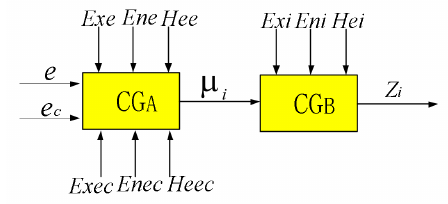
Figure 5. Biconditional rule